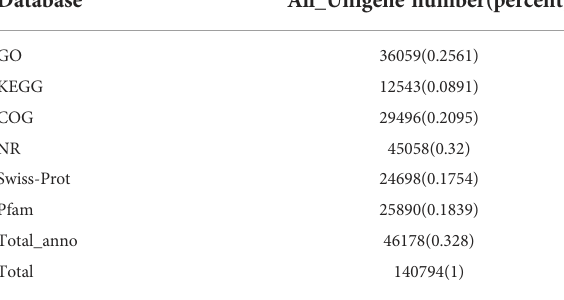
TABLE 5 Annotation information statistics.